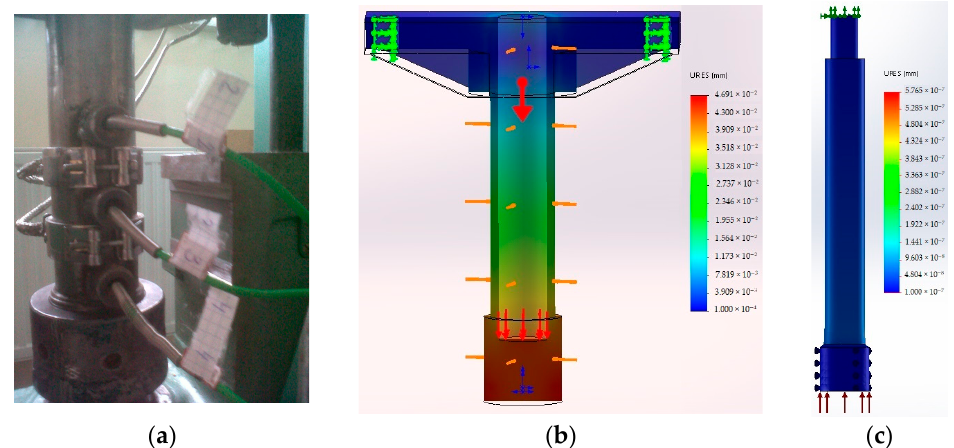
Figure 2. The actual image of ( a ) the compaction head and displacement simulation ( b ) the compaction head and ( c ) the piston.